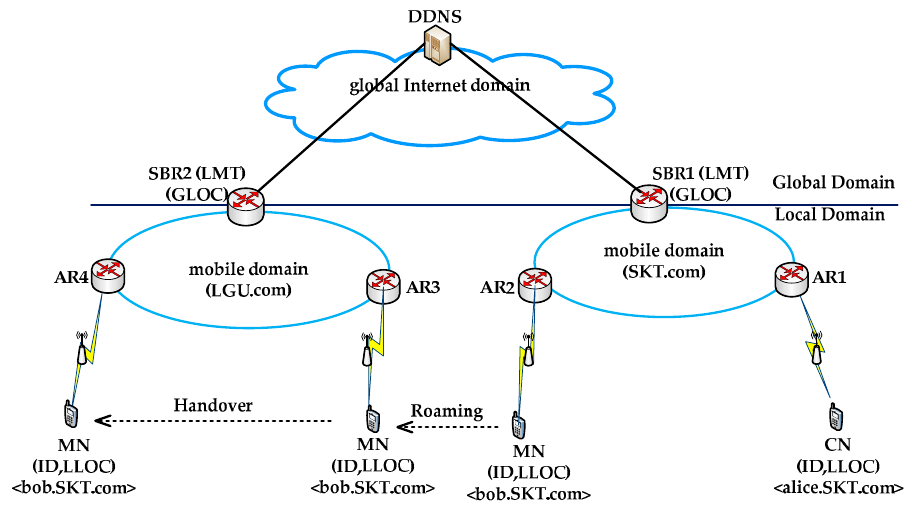
Figure 3. Mobility scenario for ILNP-Local scheme.